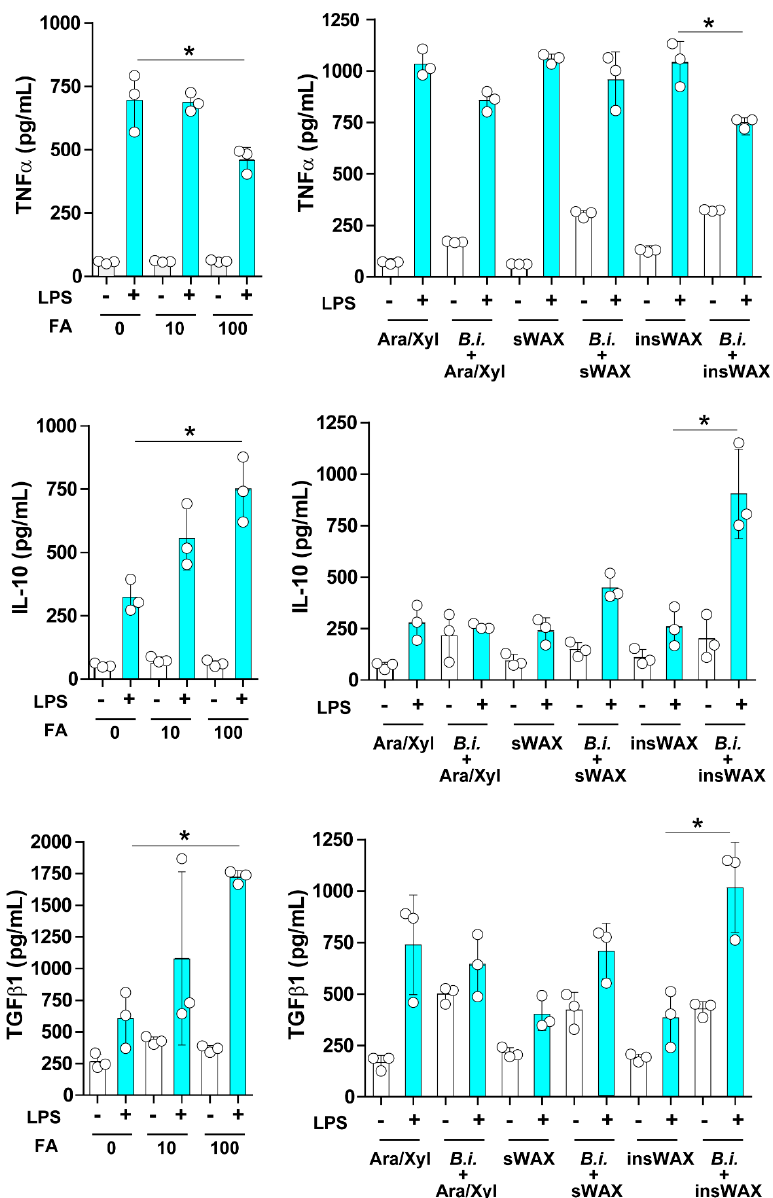
Figure 2. The culture supernatant from Bacteroides intestinalis modulated the inflammatory response under inflammatory conditions. Bone marrow-derived cells were isolated from healthy C57BL/6 mice, cultured in vitro , and differentiated to dendritic cells in the presence of Flt3. Dendritic cells were then cultured in a medium containing several concentrations (0, 10, 100 µM) of pure ferulic acid or arabinose/xylose (Ara/xylose), soluble wheat arabinoxylan (sWAX) or insoluble WAX (InWAX), or cultured in the presence of a culture supernatant from Bacteroides intestinalis grown with Ara/xylose ( B.i. + Ara/xylose), sWAX ( B.i. + sWAX), or InWAX ( B.i. + InWAX). Maturation of dendritic cells was induced with a lipopolysaccharide (LPS; 100 ng/mL). Tumor necrosis factor α (TNF α ), interleukin-10 (IL-10), and transforming growth factor β 1 (TGF β 1) were measured by enzyme immunoassays. Data are the mean ± S.D. Results from one representative experiment of two independent experiments are shown. Statistical analysis was performed using the Kruskal–Wallis analysis of variance with Dunn’s test and the Mann–Whitney U test. * p <